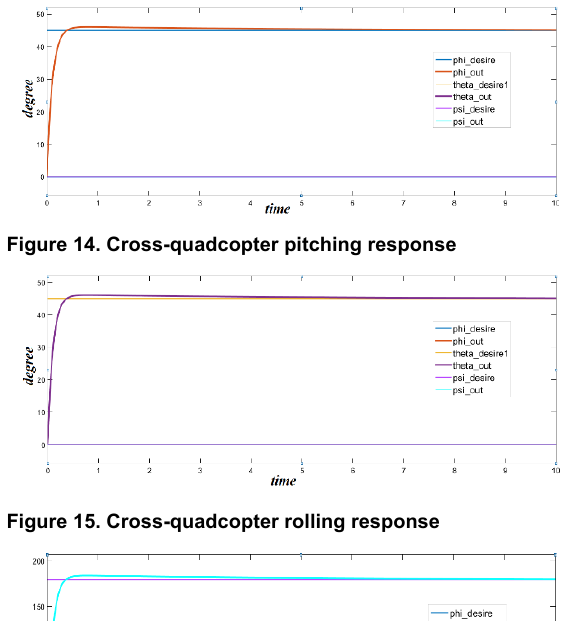
Figure 13. Plus-quadcopter yawing response